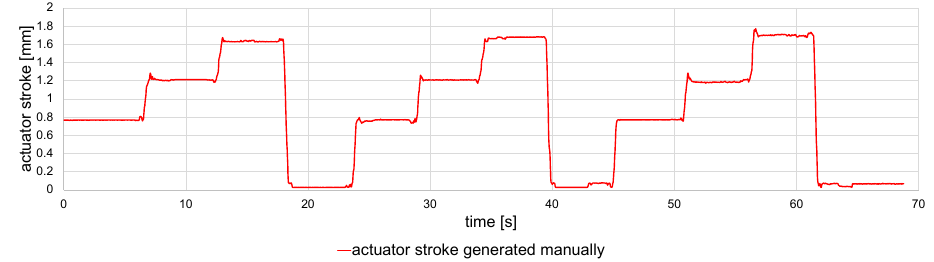
Figure 17. Stroke generated manually without using the SMA wire for activation.